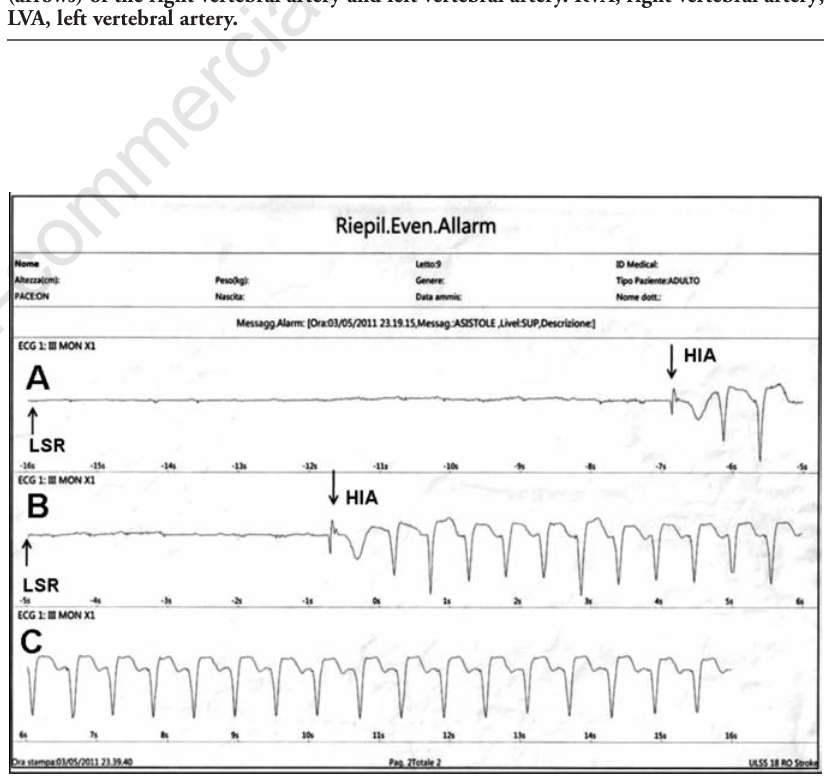
Figure 2. Continuous electrocardiographic monitoring showing sinus rhythm with com- plete atrio-ventricular block and pacing artefacts not followed by cardiac electrical activ- ity. A systolic pause lasting 9 seconds (A) associated with loss of consciousness follows left side rotation of neck. Restoration of normal pacemaker functioning (B, C) after position- ing the head in axis (HIA). LSR, left side rotation, HIA, head in